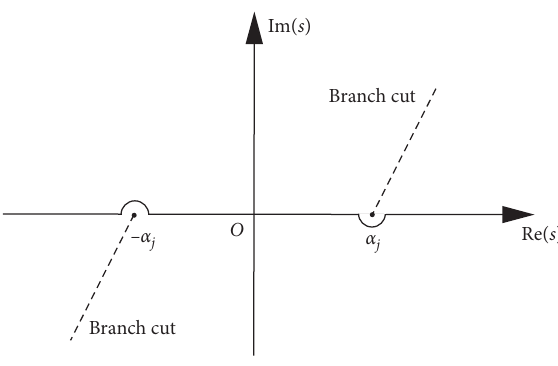
Figure 2: Integral path in s-